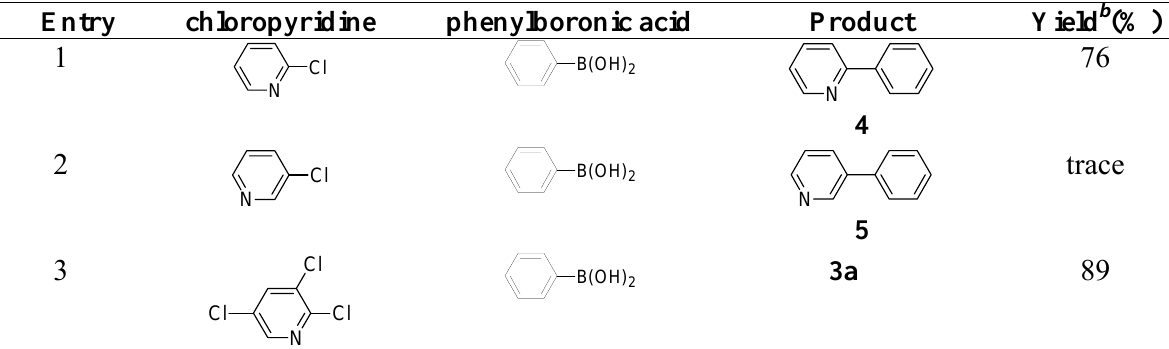
Table 4. Suzuki coupling of different chloropyridines with phenylboronic acids a